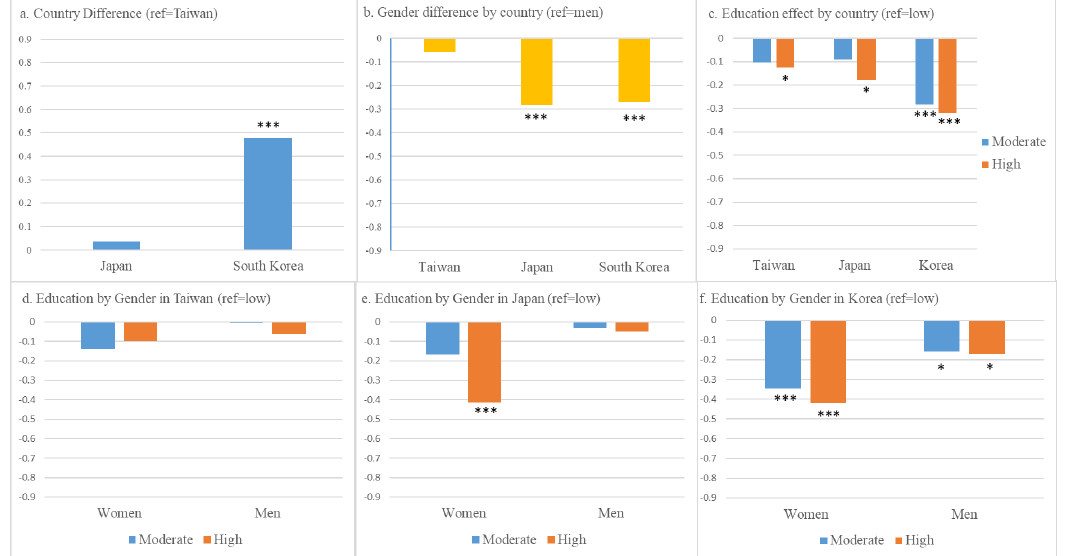
Figure 1. Gender and education effects on attitudes toward women political leadership in three Asian countries, the WVS. Note: * p < 0.05; *** p < 0.001. Figure presents average marginal effects of each factor based on logistic regression models. Positive estimates indicate higher likelihood of supporting traditional attitudes that favor men over women in political leadership. ( a ) shows the main effect of country; ( b ) shows the main effect of gender in each country; ( c ) shows the main effect of education in each country; ( d ) shows the interaction between education and gender in Taiwan; ( e ) shows the interaction between education and gender in Japan; ( f ) shows the interaction between education and gender in Korea.